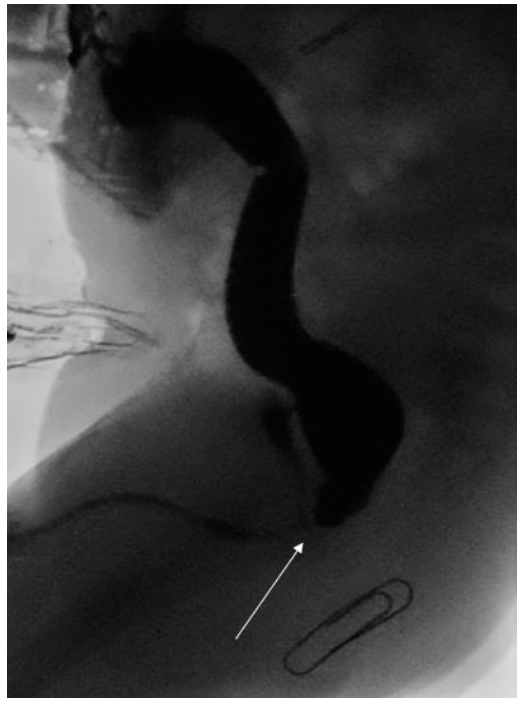
Figure 1. High pressure distal loopogram demonstrating recto-bulbar fistula (white arrow) and expected position of neo-anus (paper clip).